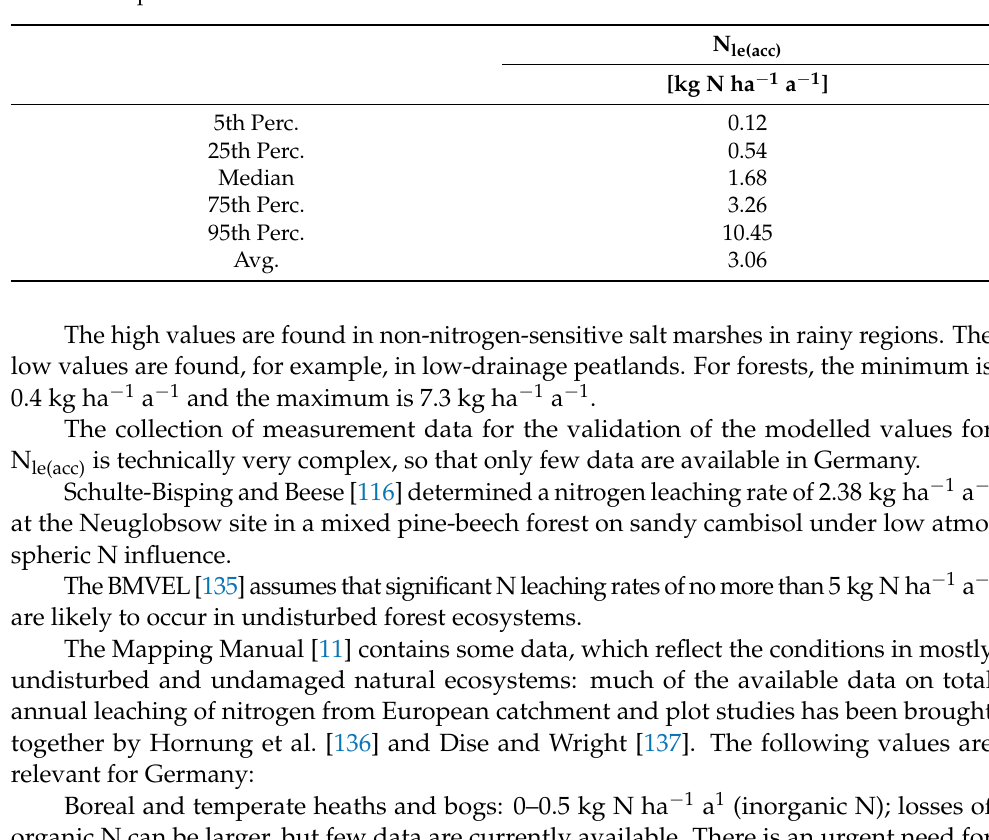
Table 16. Statistical distribution of the acceptable nitrogen leaching rate (N le(acc) ) determined for the German receptor